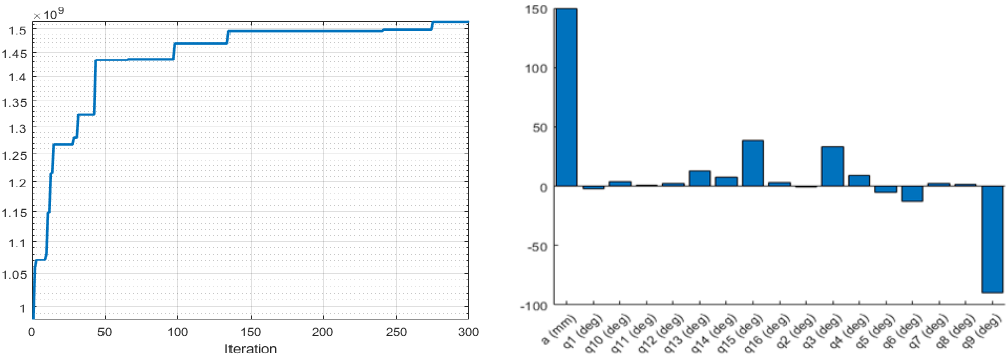
Figure 4. Objective function values ( left ), and the corresponding optimised joint parameters ( right ) for the best objective function value obtained by ABC for the Yoshikawa manipulability measure.